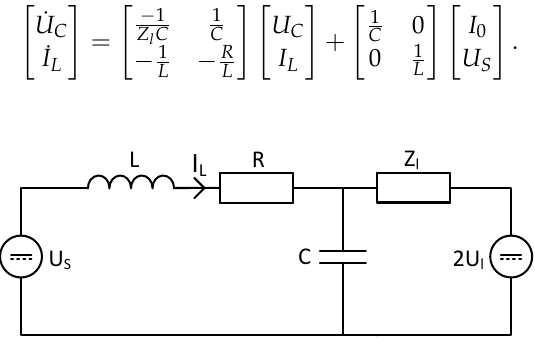
Figure 3. Simple DC distribution grid containing a constant power load and a voltage source connected via a distribution